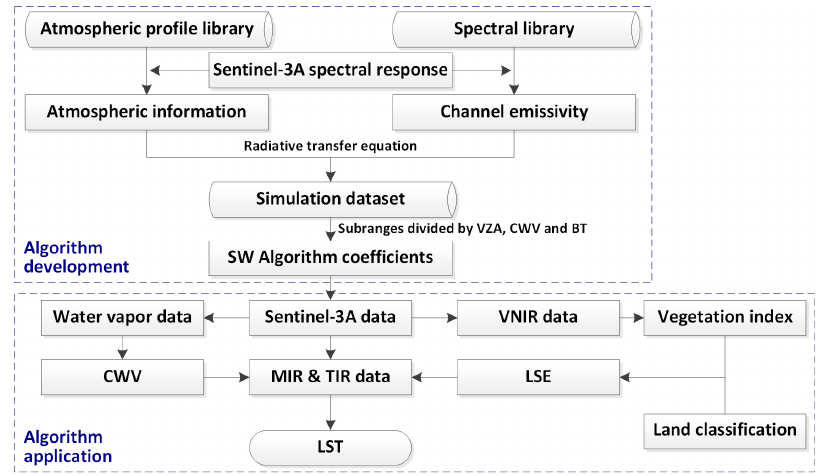
Figure 1. Technique process of the proposed algorithm.